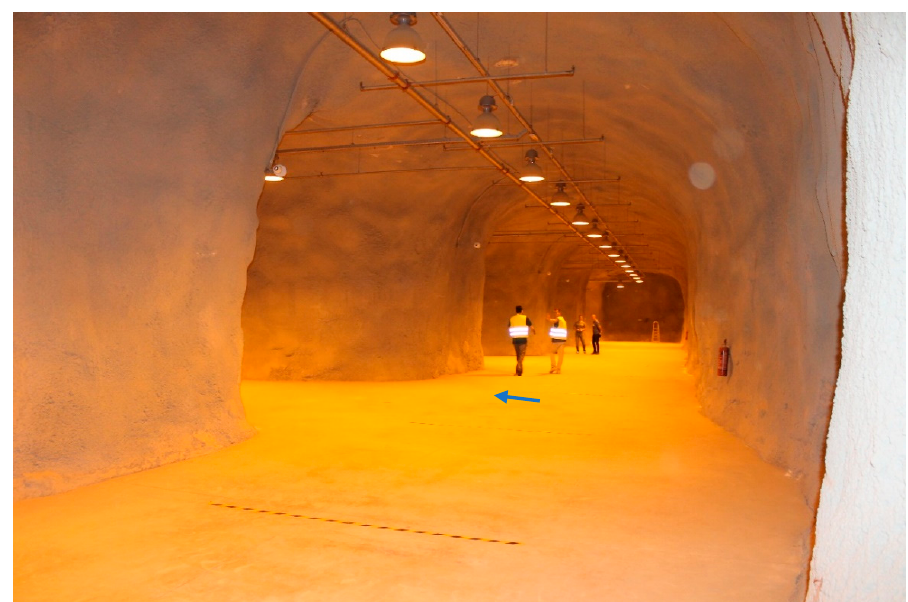
Figure 12. Self-adhesive tape placement.